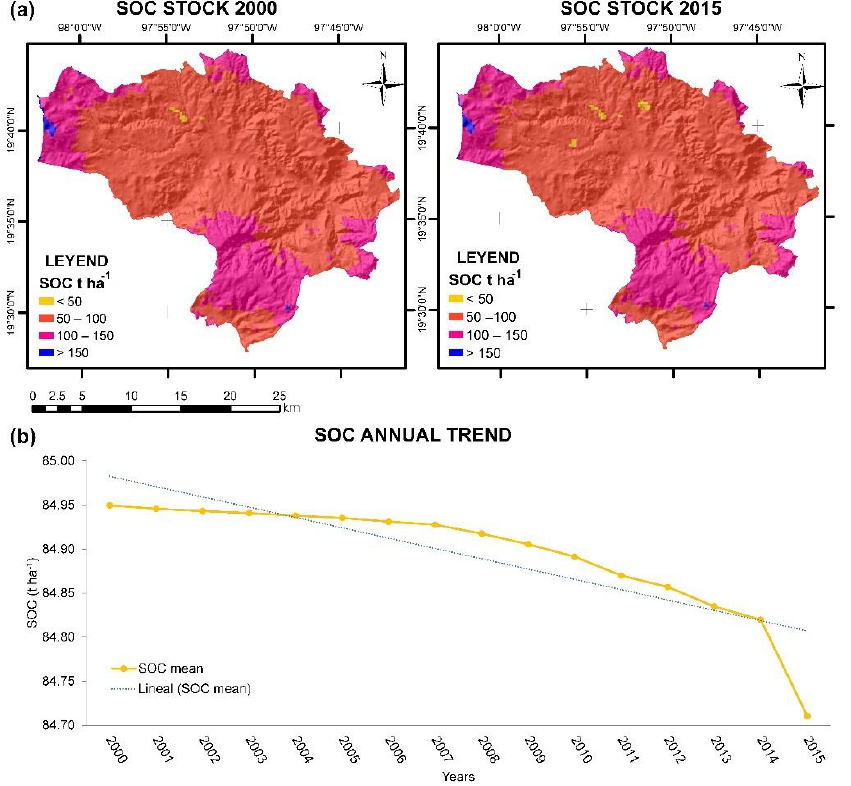
Figure 5. ( a ) Soil Organic Carbon (SOC) stock distribution for 2000 and 2015 in Ixtacamaxtitlan, Puebla, México; ( b ) Soil Organic Carbon (SOC) mean annual trend for 2000 to 2015.